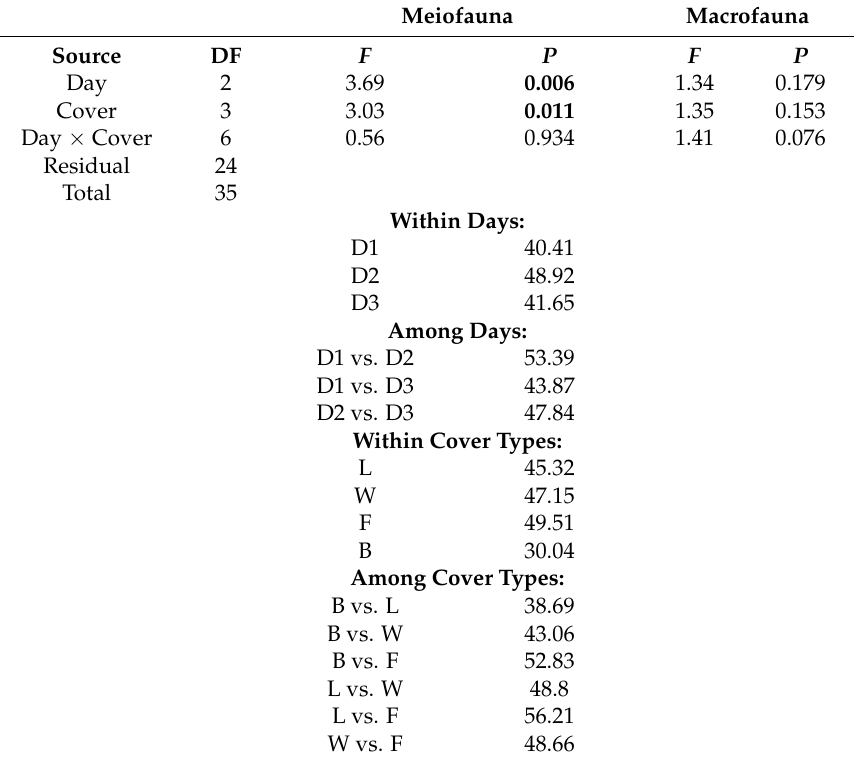
Table 3. PERMANOVA results for meiofauna and macrofauna in traps. Significant differences ( P < 0.05) are in bold. For parameters with significant differences among Days or Cover Types, the mean Bray-Curtis dissimilarity values (%) within and among Days and Cover Types are presented. L = Live mussels, W = Whole shells, F = Fragmented shells, B = Bare sediment. D1 = Day 1, D2 = Day 2, D3 = Day 3. Meiofauna